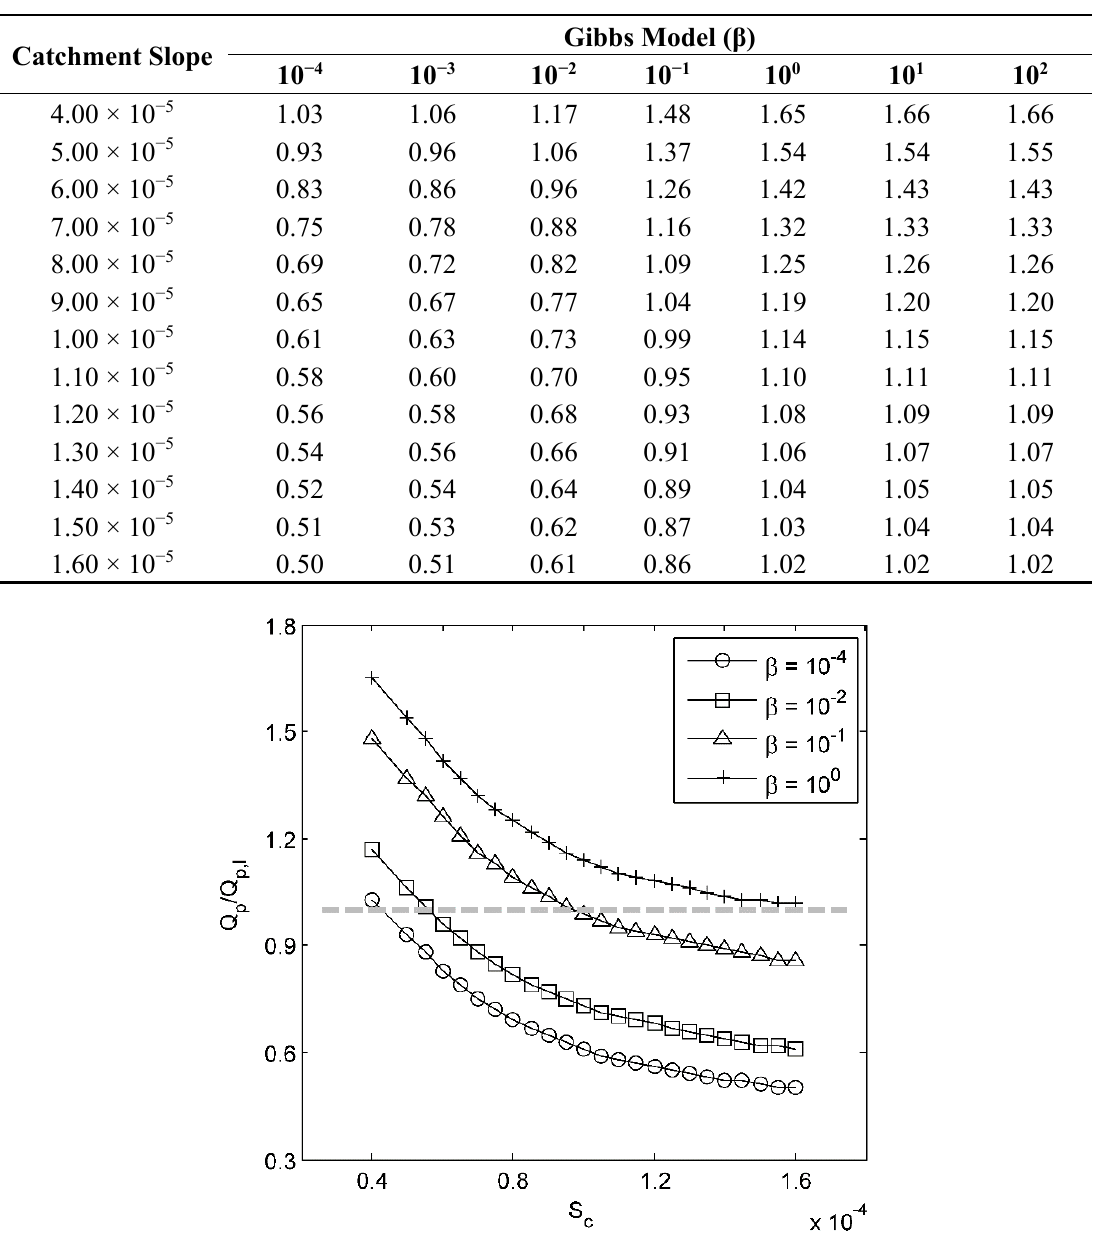
Table 1. Averaged peak flow ratio ( Q p / Q p,l ) of dendritic drainage networks generated with the Gibbsian model to the fully looped network depending on the catchment slope (rainfall intensity = 15 mm/h).